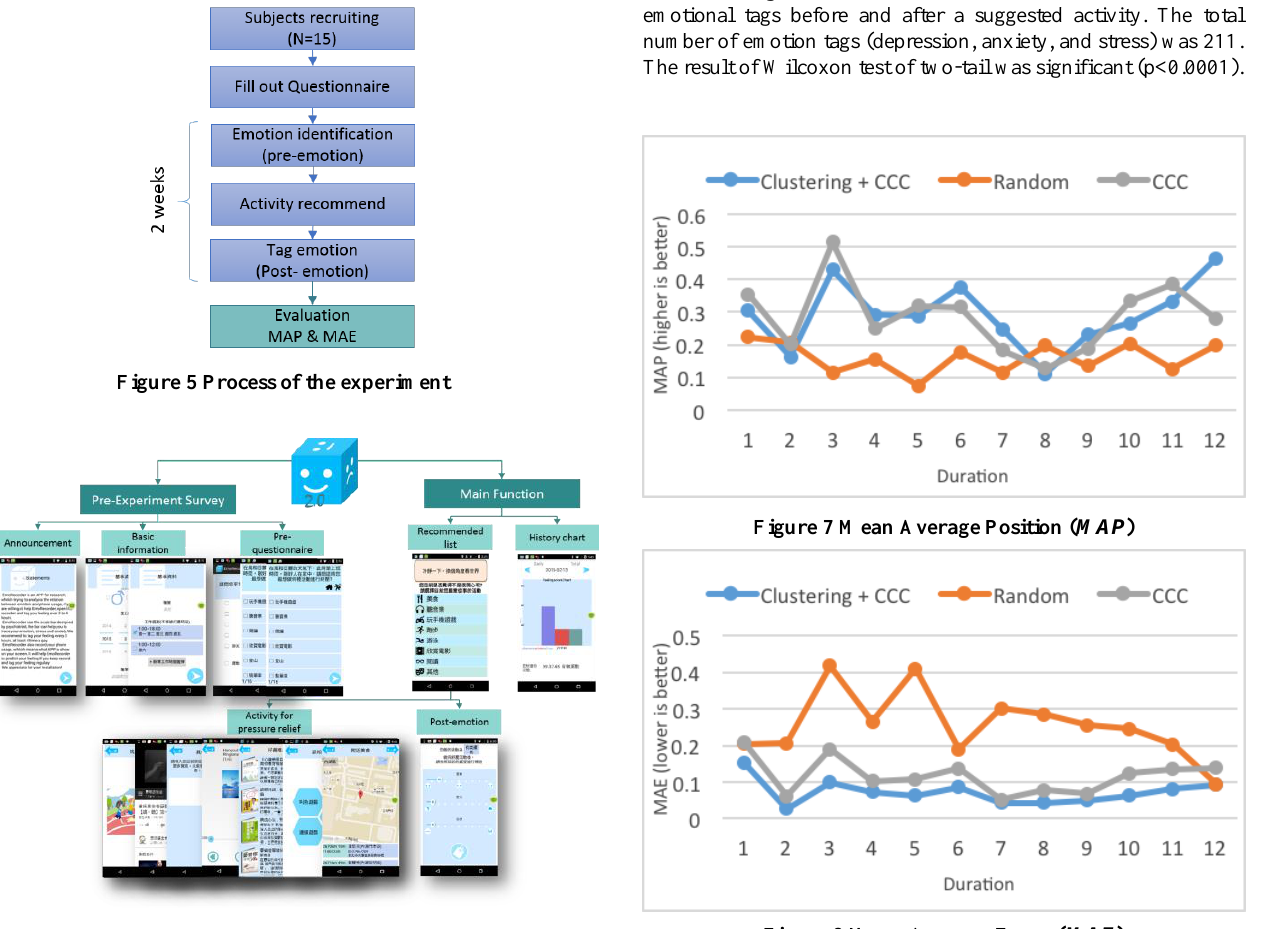
Figure 6 Overview of recommender system